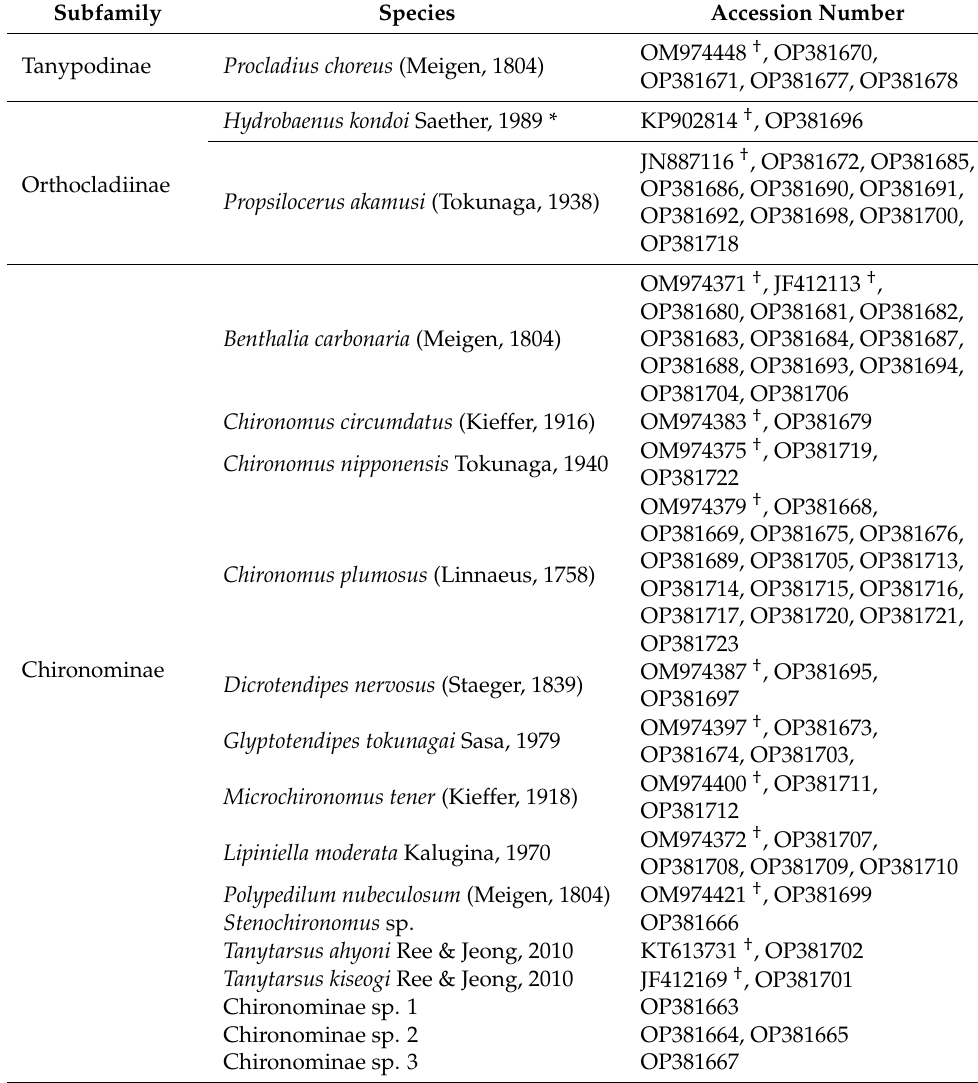
Table 1. List of larval Chironomidae taxa collected from four large rivers in South Korea and identified using a DNA barcode library in this